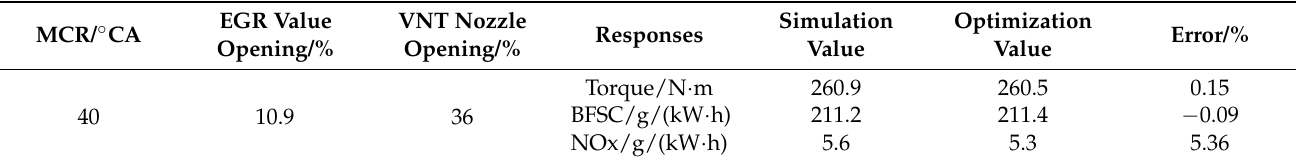
Table 6. Validation of optimized results by response surface method at engine speed 2600 r/min, 100%